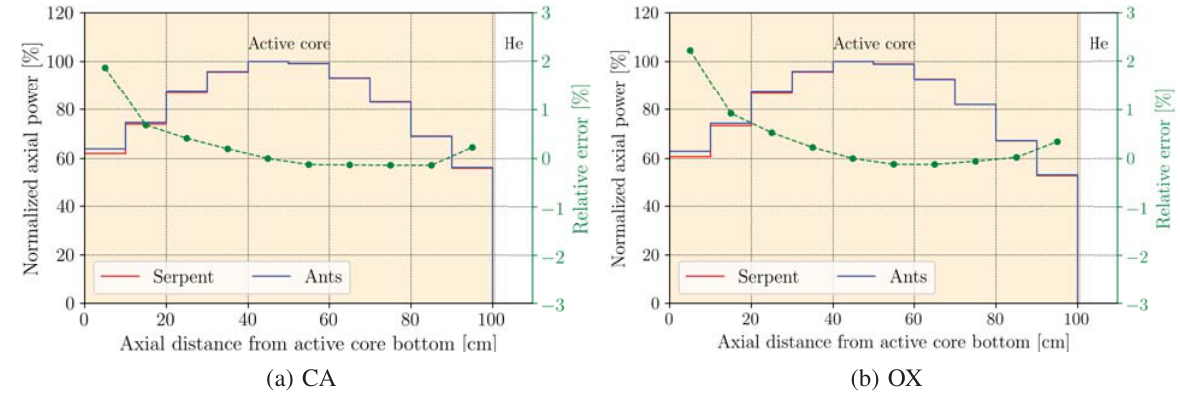
Figure 5: Axial Power Profiles in Criticality